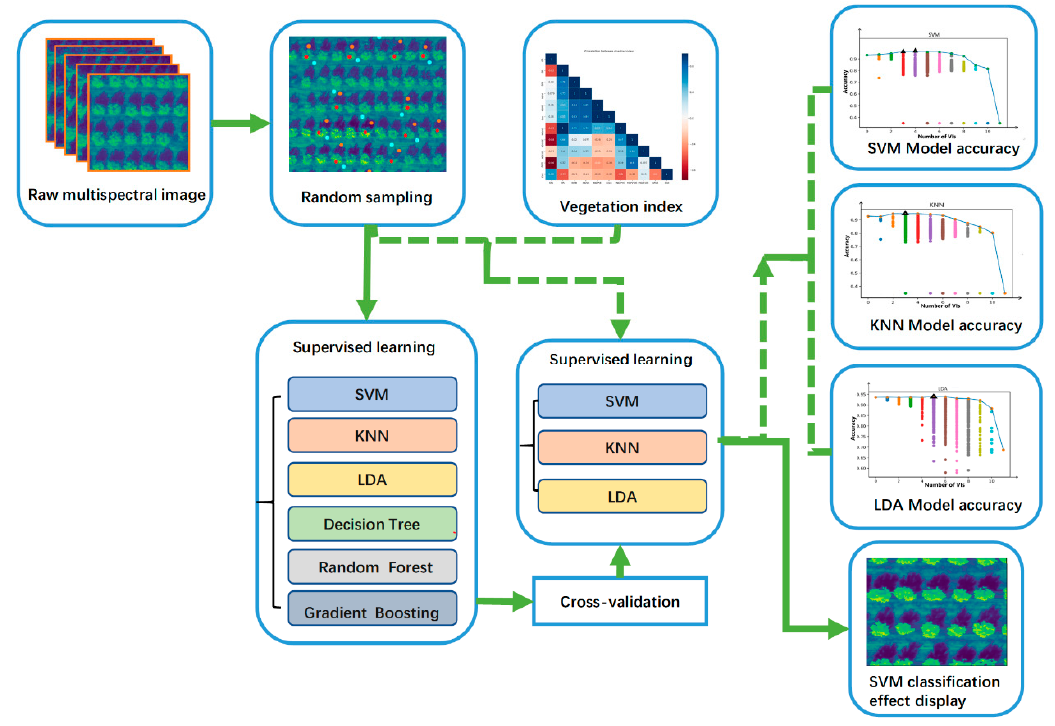
Figure 2. Flowchart of the data processing and image fusion.